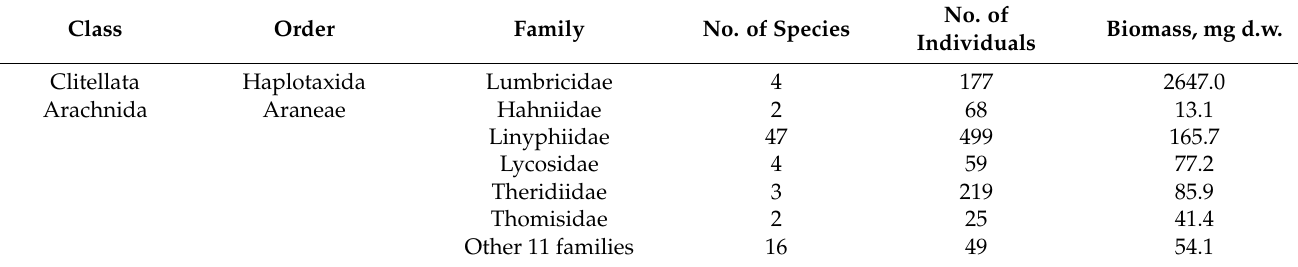
Table 1. Numbers of the collected species and individuals and biomass of major taxonomic groups of soil